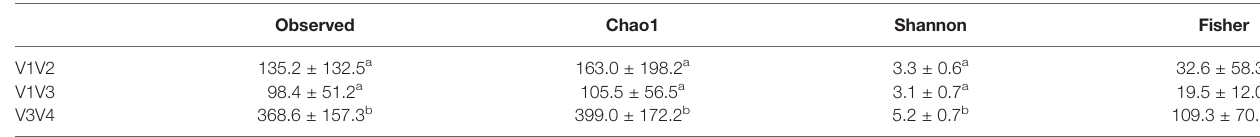
TABLE 7 | Alpha diversity estimates* of DD positive skin microbiota across different 16S rRNA hypervariable regions**.